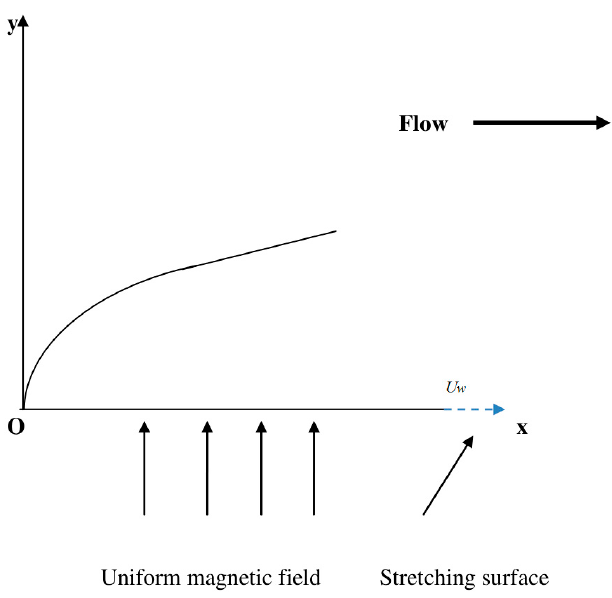
Figure 1. The geometry of the problem.